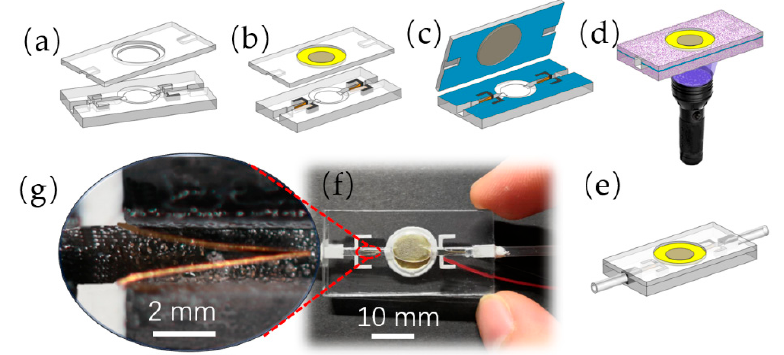
Figure 3. The fabricating process of the PZT pump: ( a ) the upper part and the lower part; ( b ) the attachment of the PZT vibrator and the compliant structures; ( c ) the coating by UV epoxy; ( d ) UV-curing; ( e ) the hoses intubating; ( f ) the fabricated PZT pump; ( g ) a detailed view of the assembled compliant structural pair.